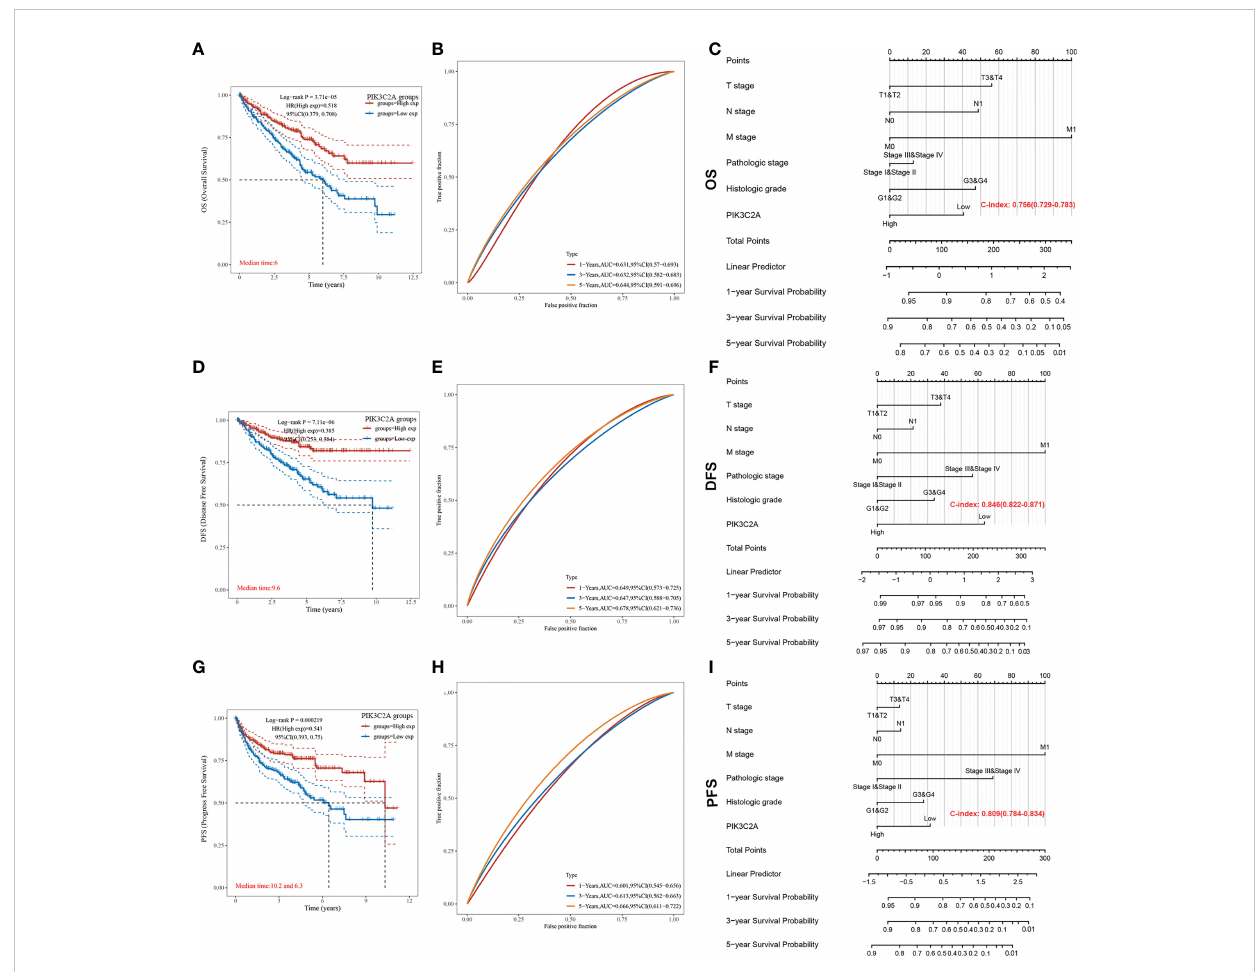
FIGURE 4 Estimating the predictive value of PIK3C2A for KIRC patients in the TCGA database. (A) Kaplan-Meier survival curve analysis for the Overall Survival of KIRC patients with high or low PIK3C2A expression. The differences between the two curves were determined by the two-sided log-rank test. (B) Time ‐ dependent ROC curve analysis of PIK3C2A for 1-year, 3- year and 5-year OS in KIRC patients. (C) The nomogram model for predicting the OS of KIRC. (D) Kaplan-Meier survival curve analysis for the Disease-Free Survival of KIRC patients with high or low PIK3C2A expression. The differences between the two curves were determined by the two-sided log-rank test. (E) Time ‐ dependent ROC curve analysis of PIK3C2A for 1-year, 3-year and 5-year DFS in KIRC patients. (F) The nomogram model for predicting the DFS of KIRC. (G) Kaplan-Meier survival curve analysis for the Progress Free Survival of KIRC patients with high or low PIK3C2A expression. The differences between the two curves were determined by the two-sided log-rank test. (H) Time ‐ dependent ROC curve analysis of PIK3C2A for 1-year, 3-year and 5-year PFS in KIRC patients. (I) The nomogram model for predicting the PFS of